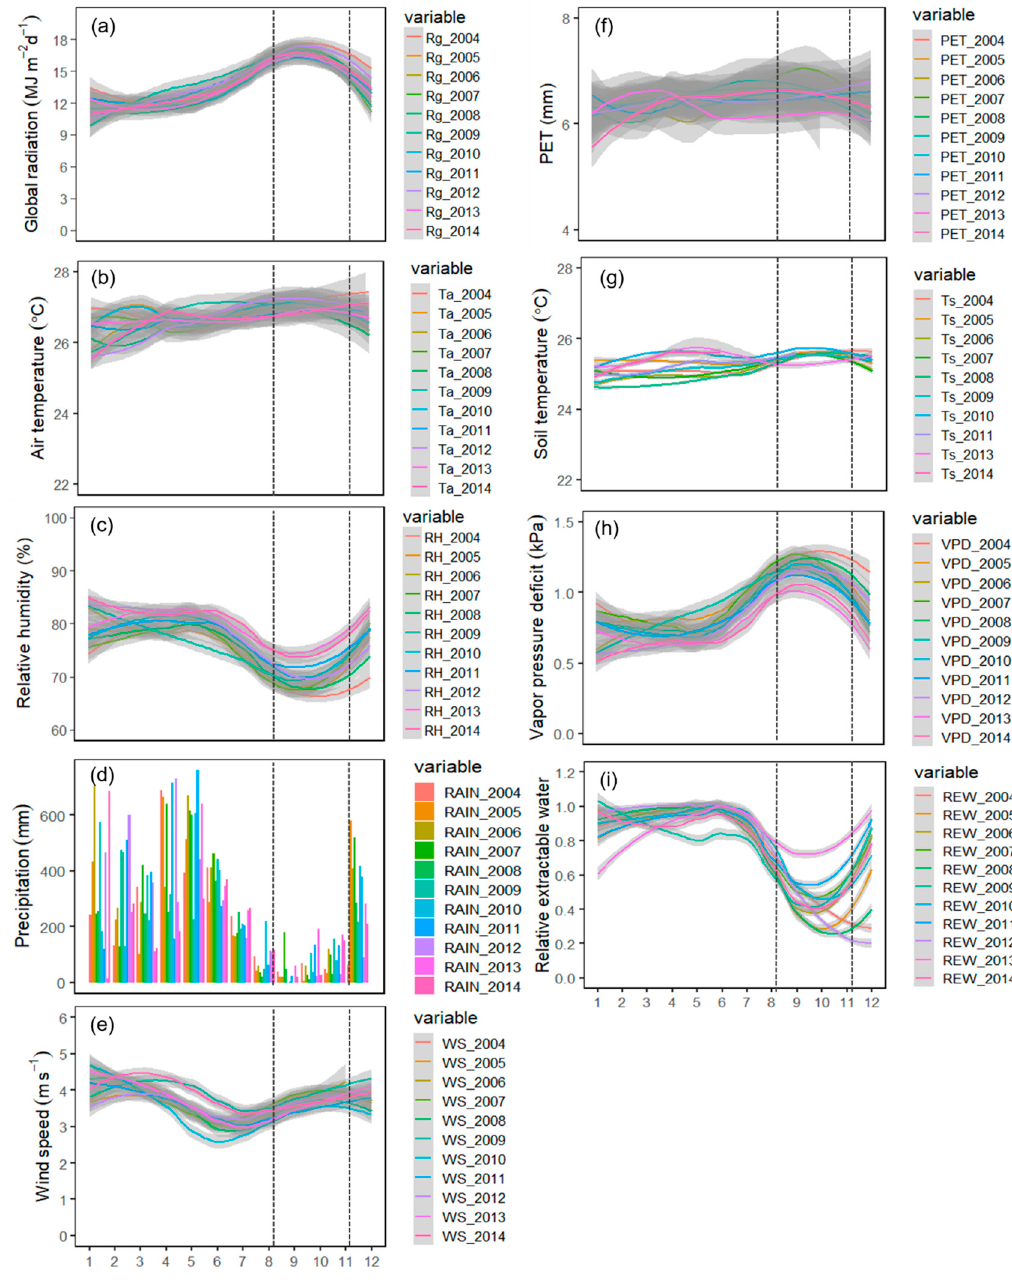
Figure 3. Interannual and seasonal variations for climate variables. ( a ) Global radiation (Rg, MJ m − 2 d − 1 ), ( b ) Air temperature (Ta, ◦ C), ( c ) Air relative humidity (RH, %), ( d ) Precipitation (Rain, mm), ( e ) Wind speed (WS, m s − 1 ), ( f ) Potential Evapotranspiration (PET, mm), ( g ) Soil temperature (Ts, ◦ C), ( h ) Vapor pressure deficit (VPD, kPa), ( i ) Relative extractable water (REW, unitless). Different colors were assigned for each year. Gray-shaded regions are the confidence intervals and the colored line in the grayscale line is the smooth curve. The two vertical broken lines in each panel represent the average day of the year for the beginning and end of the WD period. Monthly sums for precipitation in ( d ) are presented in a bar plot.